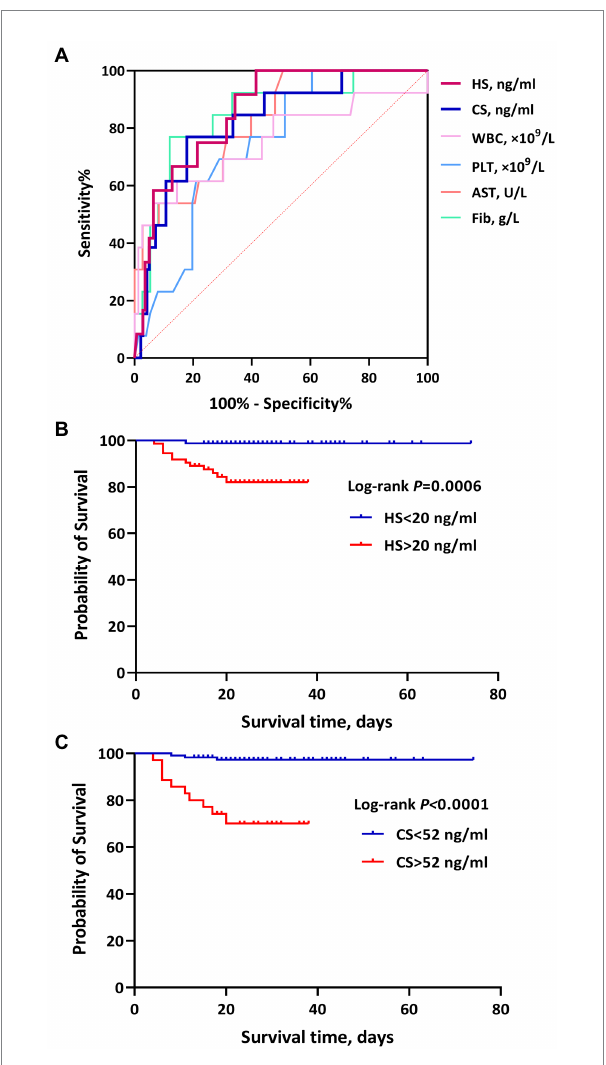
FIGURE 3 The ROC curves and survival curves of heparan sulfate (HS) and chondroitin sulfate (CS) for the prognosis (death) of hemorrhagic fever with renal syndrome (HFRS). (A) shows the predictive efficacy of HS, CS, white blood cells (WBC), platelets (PLT), aspartate transaminase (AST), and Fib for the prognosis (death) in patients with HFRS. HS and CS showed significant predictive values, with an AUC of 0.871 and 0.822, respectively. (B) and (C) represent the association of HS and CS with mortality in HFRS, respectively. Higher levels of HS and CS showed a higher risk of